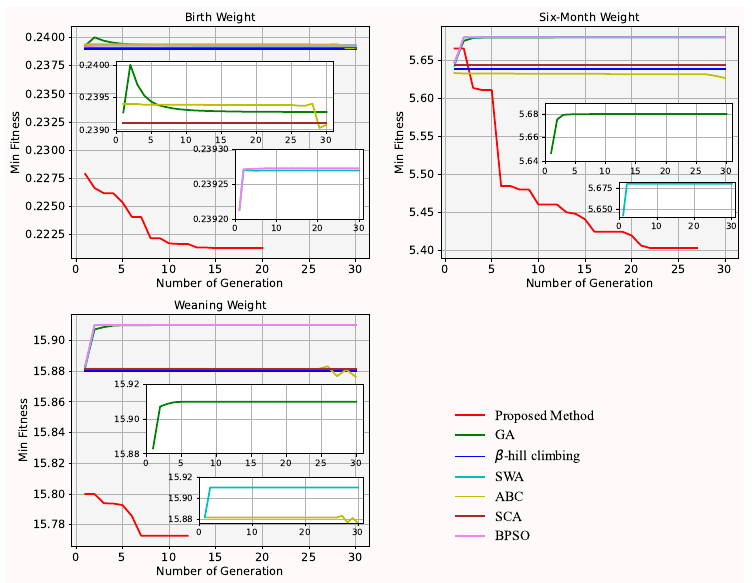
Figure 5. Min fitness value of GA and the proposed method for the body weights on each of the three